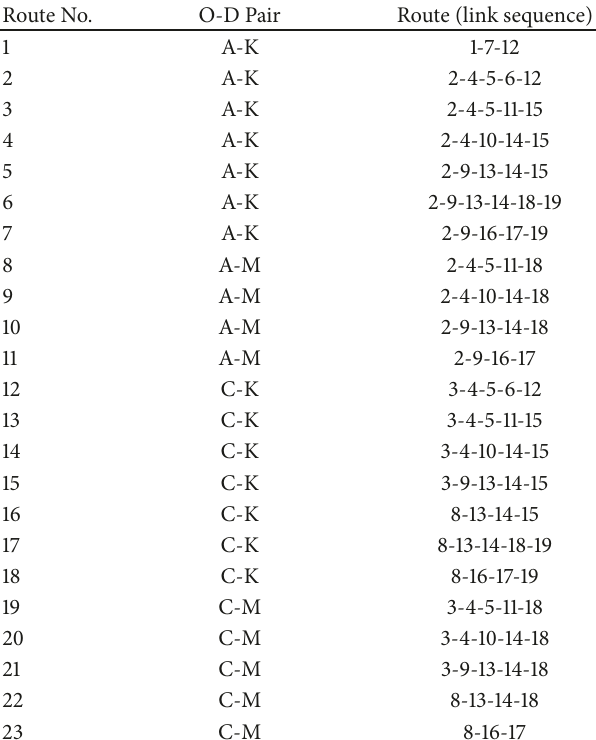
The quantity of vehicles travelling between each of the four O-D pairs is defined by matrices 𝑁 1 and 𝑁 2 representing, respectively, the high congestion case and the low